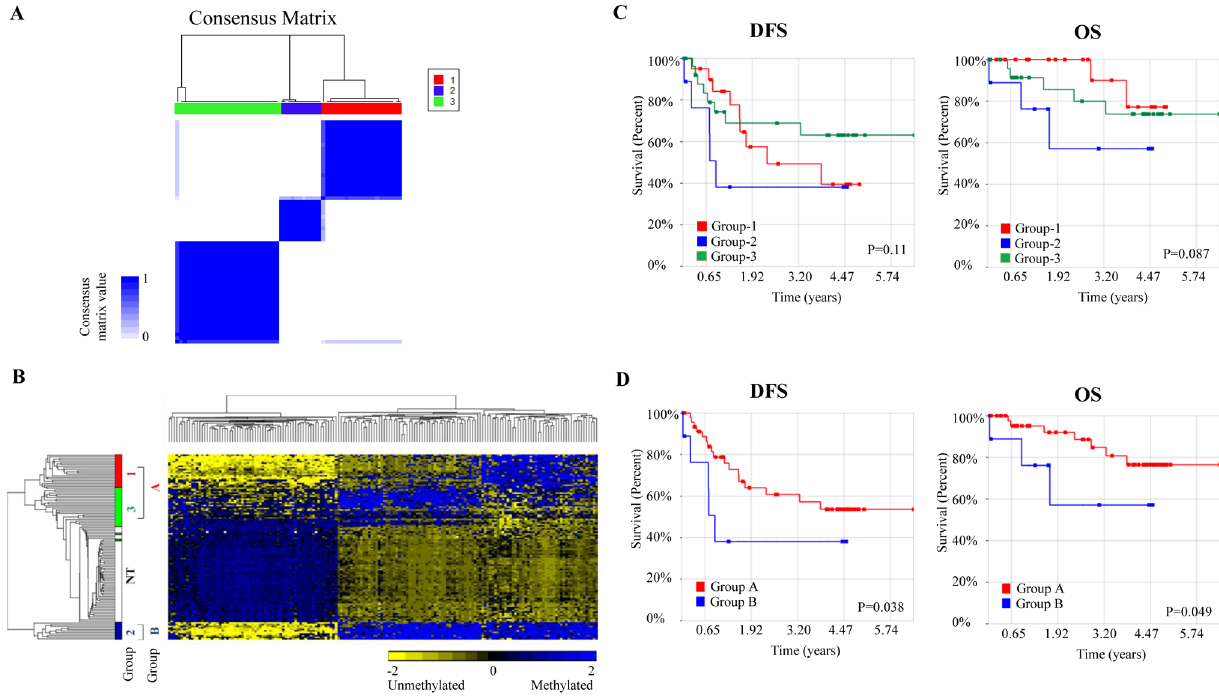
Figure 1. Clustering analysis of 59 HCC tumors reveals 3 subgroups. (A) Consensus matrix (B) 2D hierarchical clustering of 170 probes that overlapped between 4416 differentially methylated CpG sites (between tumors and adjacent non-tumorous tissues) and 199 CpG loci that divided tumors into three subgroups. Subgroups were labeled as Group-1 (red), Group-2 (blue), Group-3 (green) and adjacent non-tumorous tissues, NT (white). Group A represents both Group-1 and Group-3, while Group B is Group-2. (C) Survival curves for the original 3 subgroups identified by CHC- FS. (D) Survival curve for Group B versus Group A. P-value was calculated by generalised Wilcoxon method. OS, overall survival; DFS, disease free